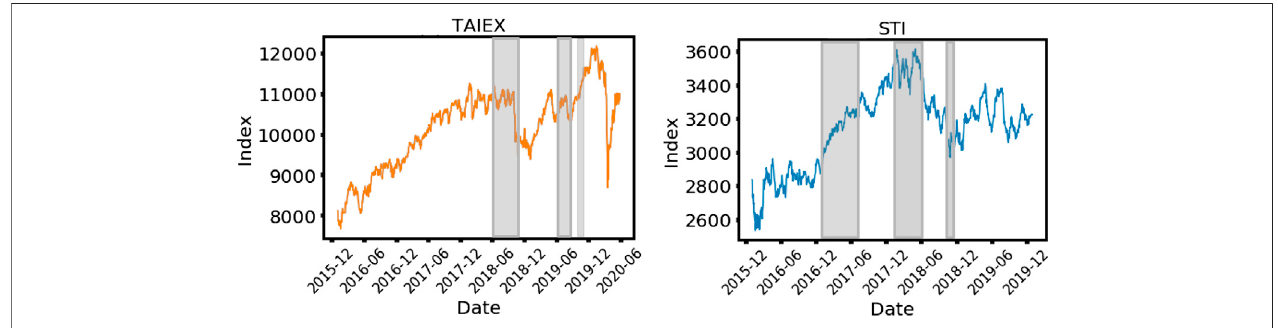
FIGURE 11 | The (A) TAIEX and (B) STI index for the past fi ve years, which include the period we collected our data. For TAIEX, the period is from Jan 01, 2017 to Mar 31, 2020. For STI, the period is from Jan 01, 2017 to Apr 30, 2019. In this fi gure, the gray bands are periods seen from Figure 14 where the Euler characteristic is